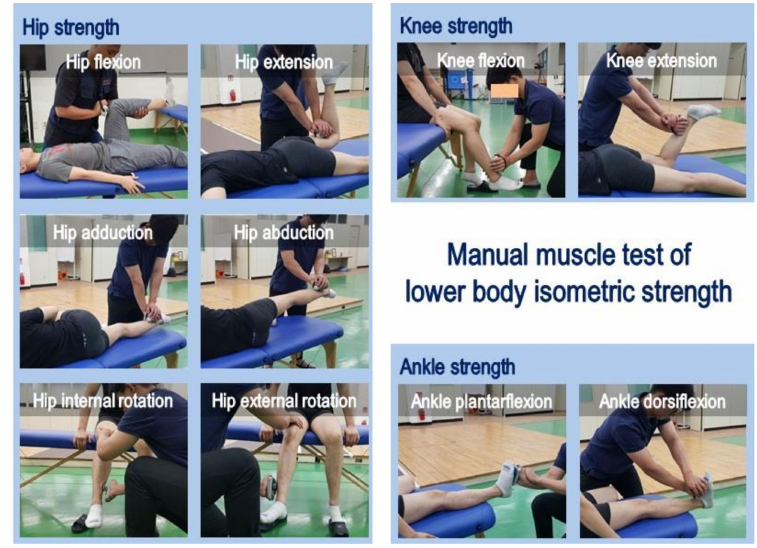
Figure 1. Manual muscle test of lower body isometric strength.